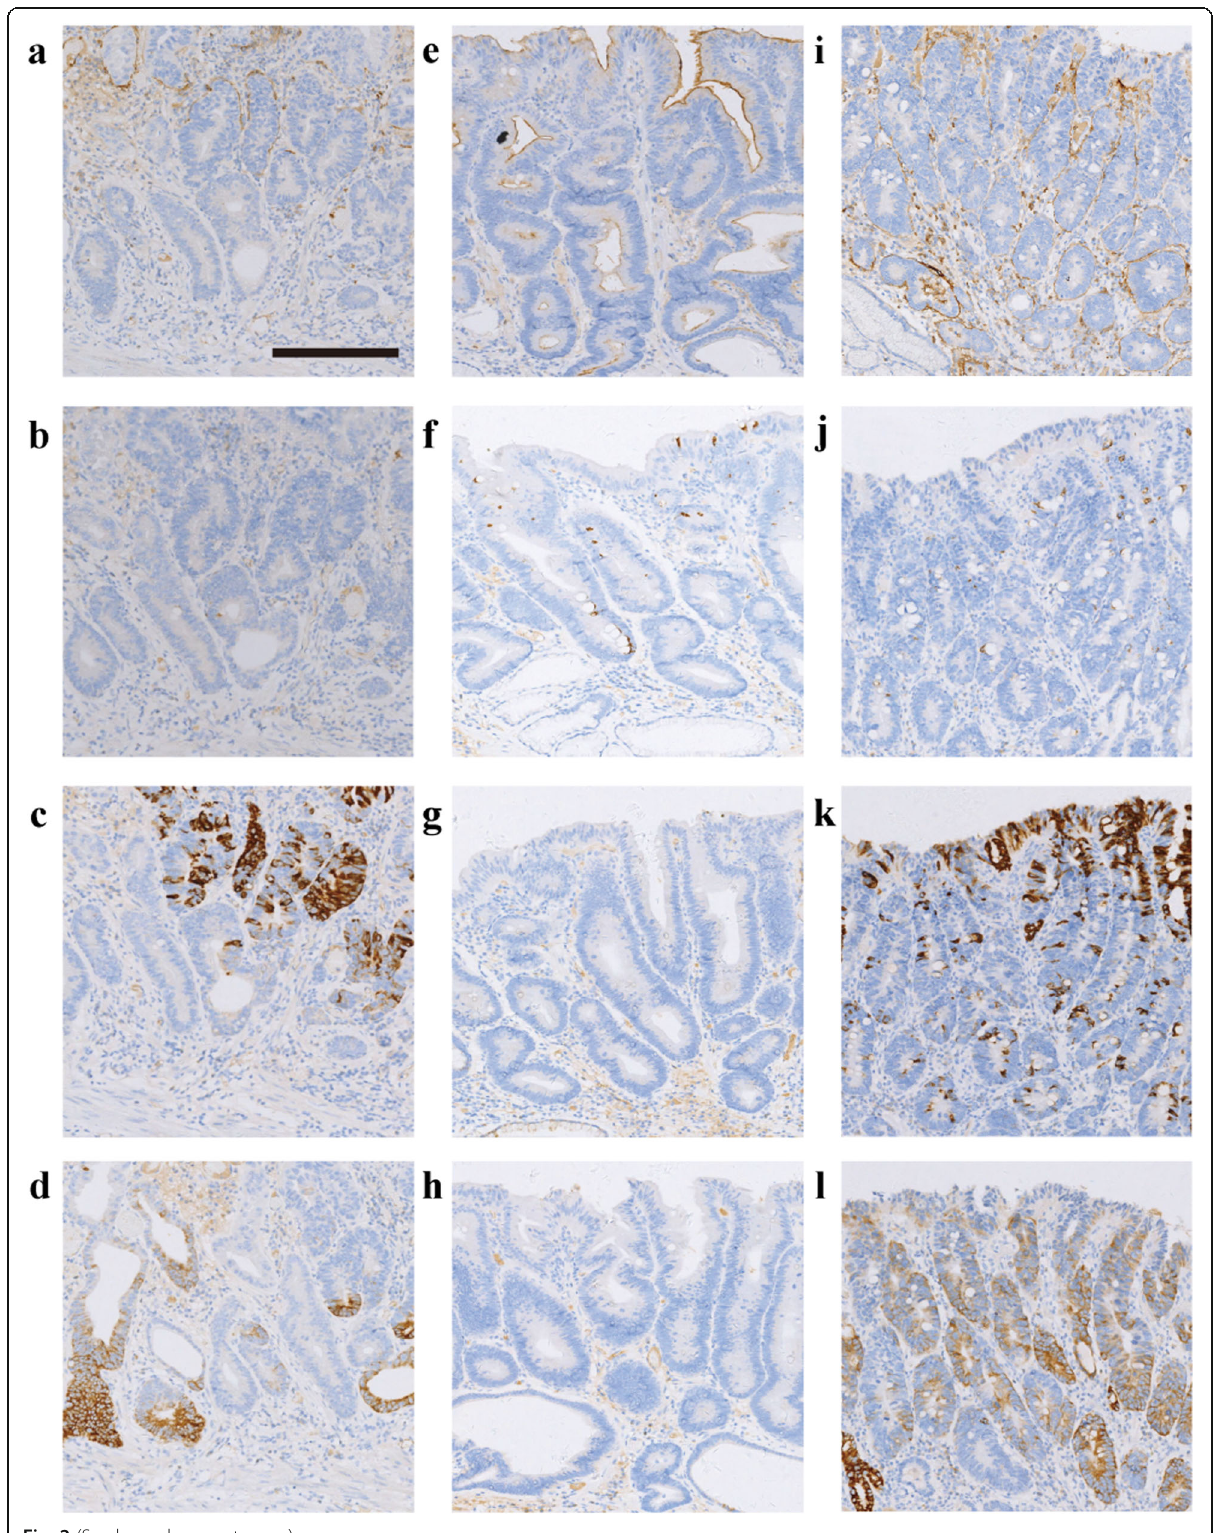
Fig. 2 (See legend on next